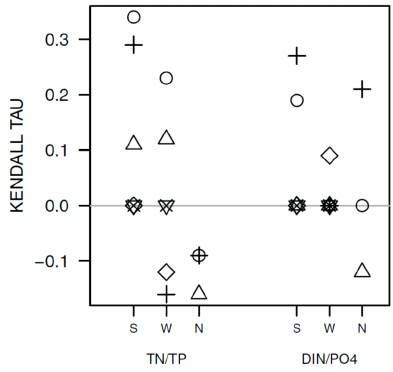
Figure A9. Summary of monotonic long-term trends in N:P ratios for both total and inorganic nutrient fractions. For details see Figure 4.